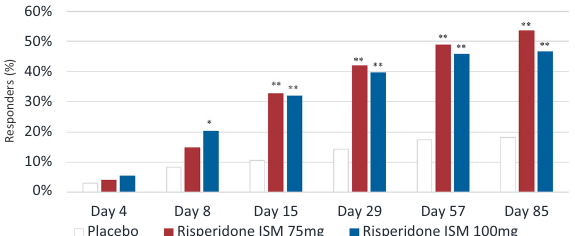
Table 5. Injection site pain (safety population).